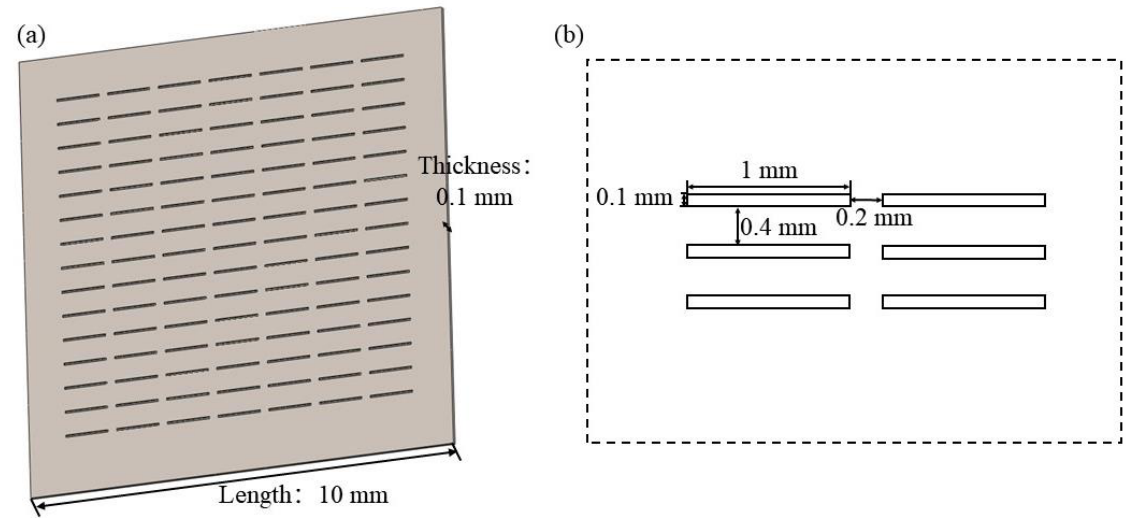
Figure 2. Schematics of contact foil size ( a ) and texture size ( b ).